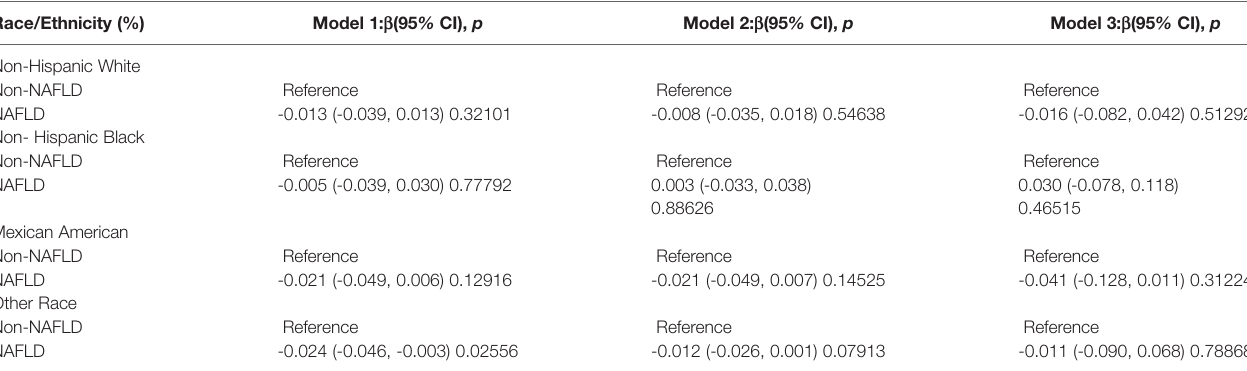
Model 1: No covariates were adjusted. Model 2: Age, gender, race were adjusted. Model 3: Age, gender, race, body mass index, poverty to income ratio, education, smoking behavior, Moderate activities, Diabetes status, Waist circumference, HbA1c (%), Total cholesterol, Triglyceride, LDL- cholesterol, HDL- cholesterol, ALT, ALP, GGT, AST, Serum creatinine, Serum iron, Lumbar bone mineral density, CAP and LSM were adjusted. *In the subgroup analysis strati fi ed by gender or race, the model is not adjusted for the strati fi cation variable